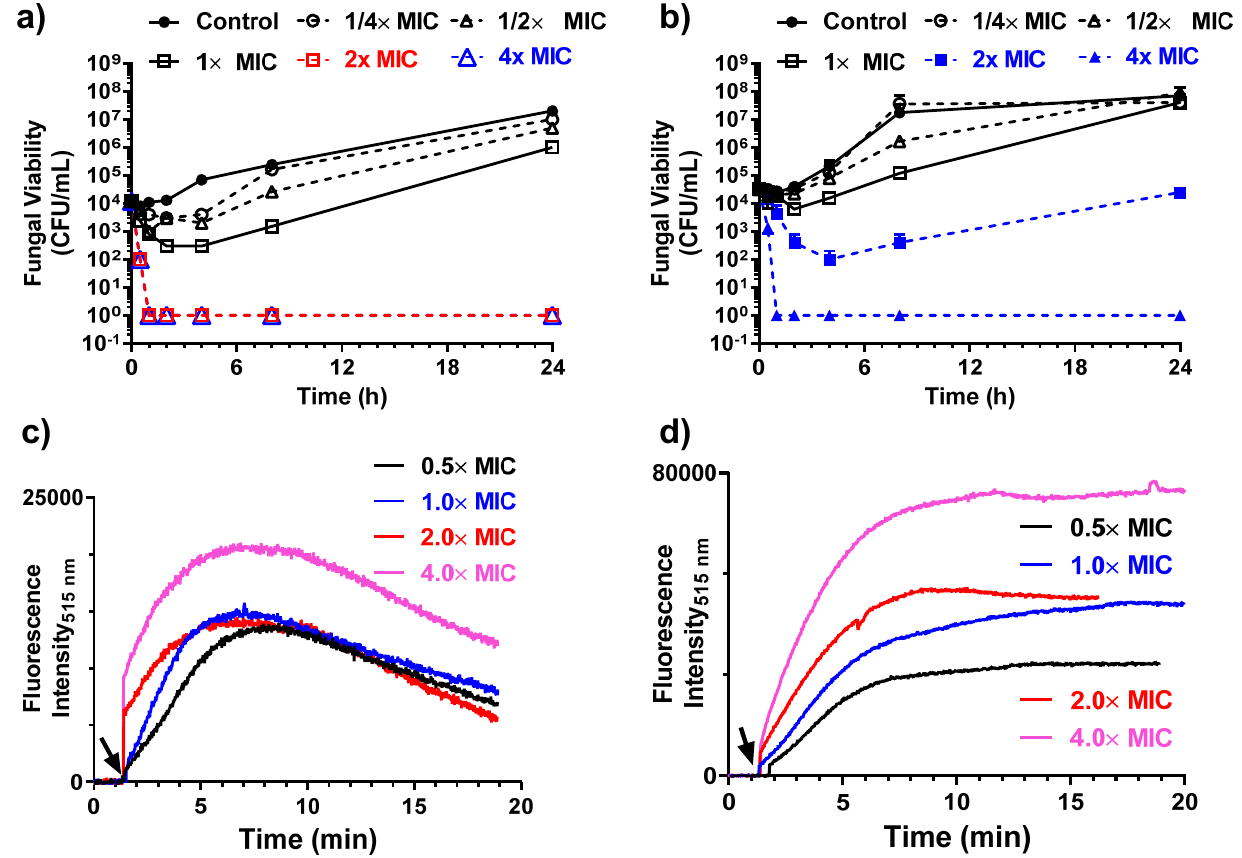
Figure 4. Time–kill kinetics of MB peptides against ( a ) C. parapsilosis 1002 and ( b ) C. glabrata 1003 strains. Sytox green uptake showing concentration-dependent changes in the dye uptake upon addition of MB to ( c ) C. parapsilosis 1002 and ( d ) C. glabrata 1003 strains. MIC value of MB against both the strain is 4.96 µ M. The black arrow indicates the time of addition of MB peptide. The concentration of peptide is expressed in terms of MIC×.